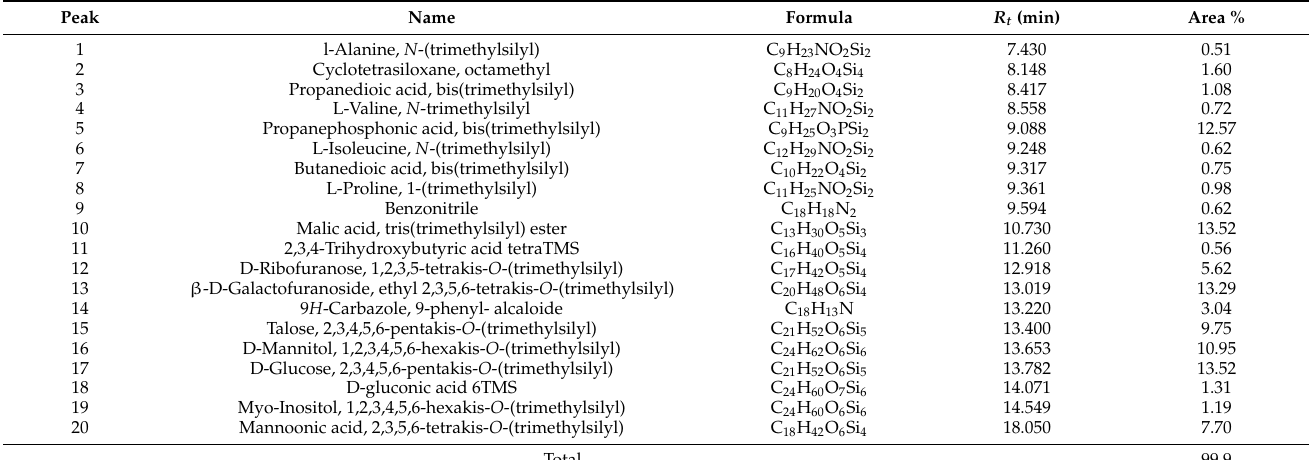
Table 2. Identified compounds by GC-MS in the hydro-ethanolic extract of P. sativum